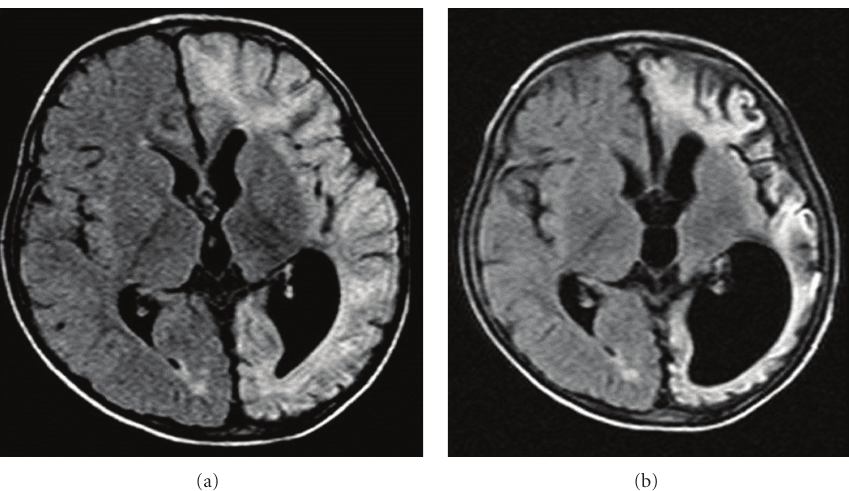
Figure 3: T2W Axial flair MRI images of a patient with Rasmussen’s encephlitis taken six months apart showing progression of disease.